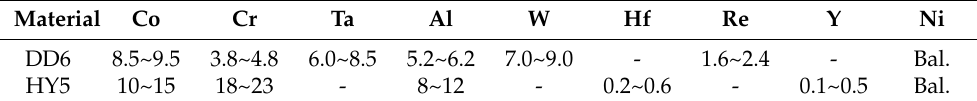
Table 1. Chemical compositions of the DD6 single crystal superalloy and HY5 coating (in wt.%).